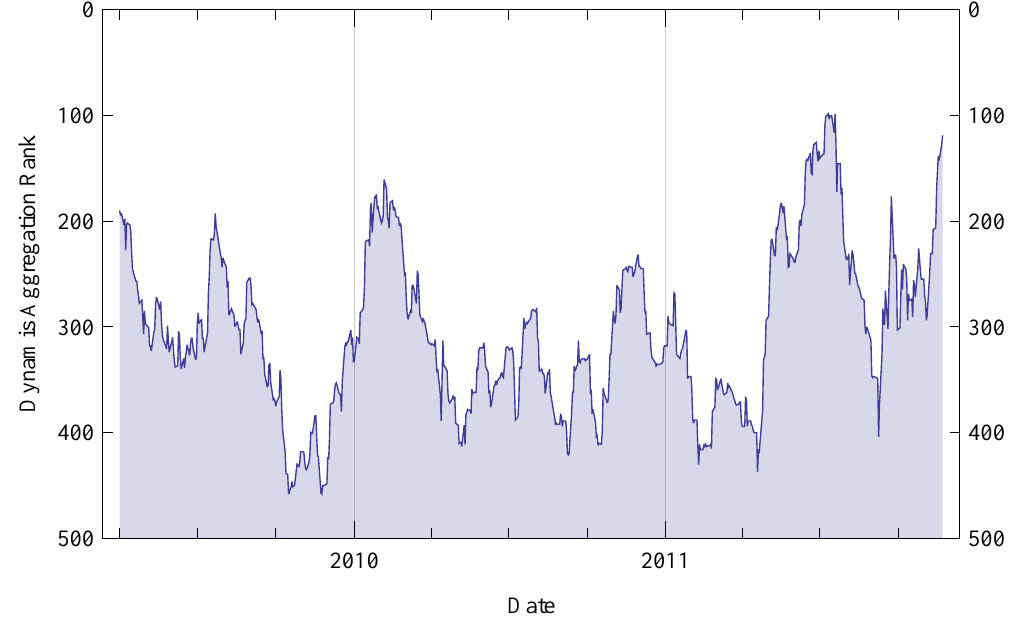
Figure 8. INTC rank as its score (Dynamis aggregation) changes over time in a pool of 500 tickers. A lower-numbered rank (visually higher in the graph) means a higher